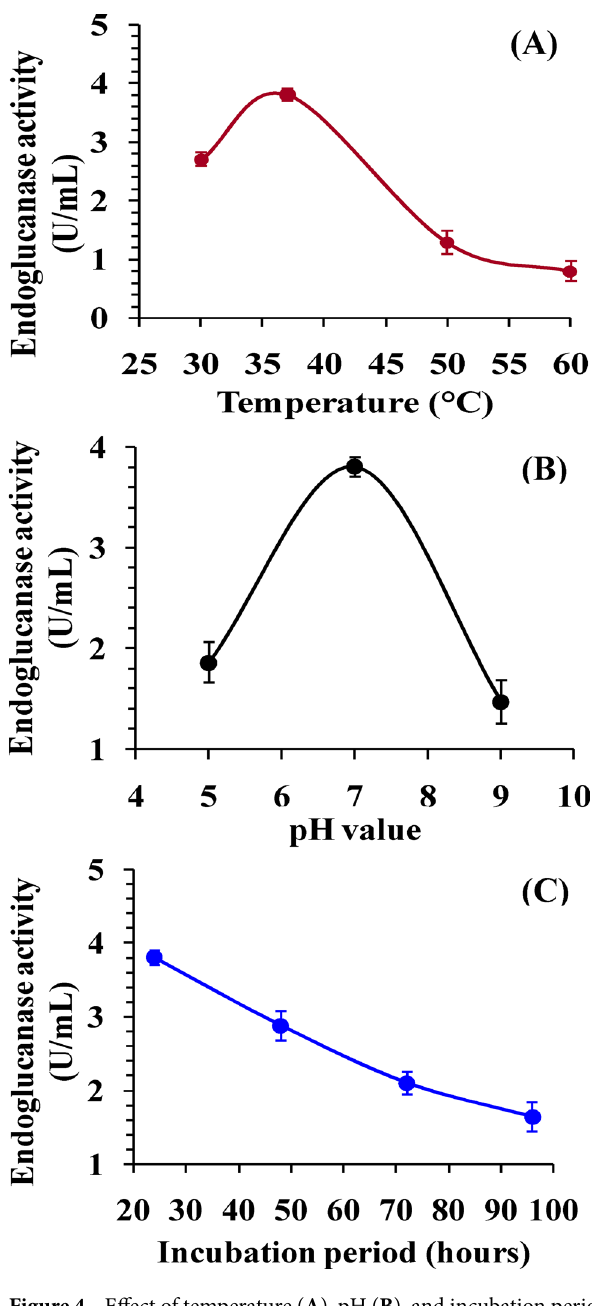
Figure 4. Effect of temperature ( A ), pH ( B ), and incubation period ( C ) on endoglucanase